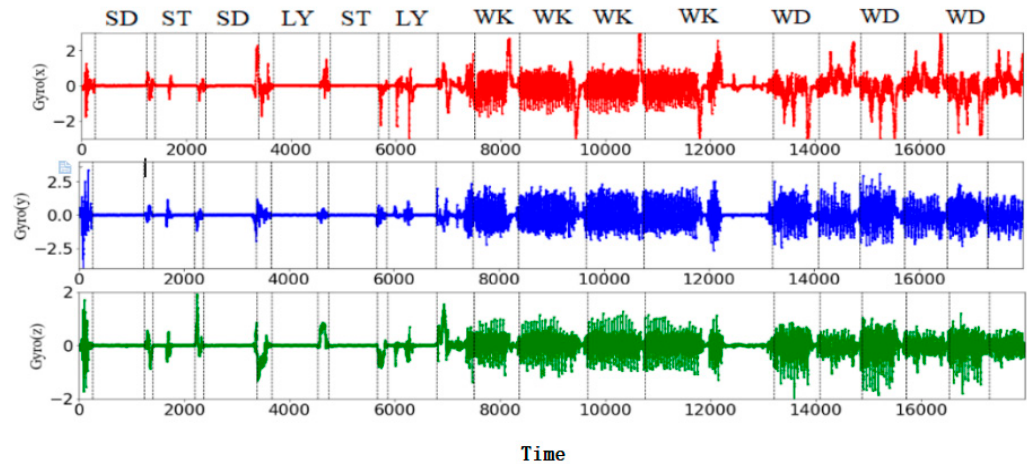
Figure 3. Example of inertial signals from the gyroscope while performing six activities.